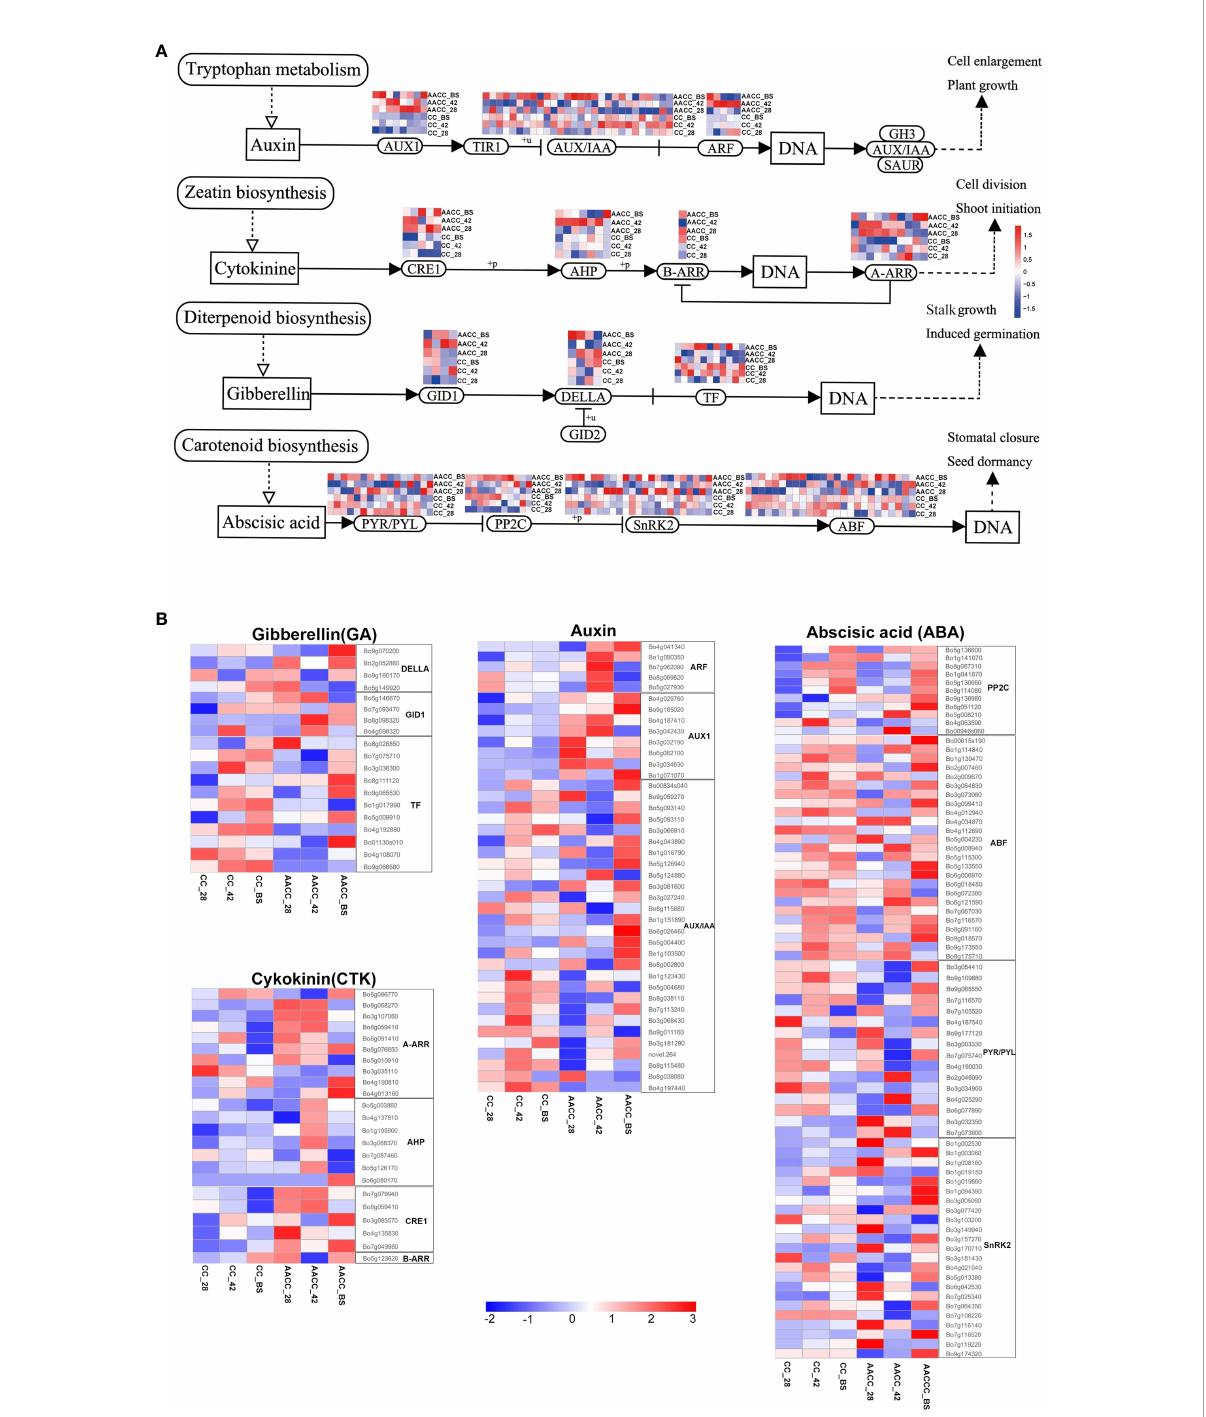
FIGURE 5 Expression characteristics of hormone signaling related genes in stem growth and development of CC and its AACC. (A) Response of auxin, cytokinin, gibberellin and abscisic acid signal transduction genes in stem growth and development of CC and AACC. (B) Heatmap of the expressed genes assigned to hormone signal transduction pathway in the six stem transcriptomes including CC_28, CC_42, CC_BS, AACC_28, AACC_42, and AACC_BS. The log-transformed expression values range from -2 to 3. Red and blue colors indicate up-regulated and down- regulated transcripts,